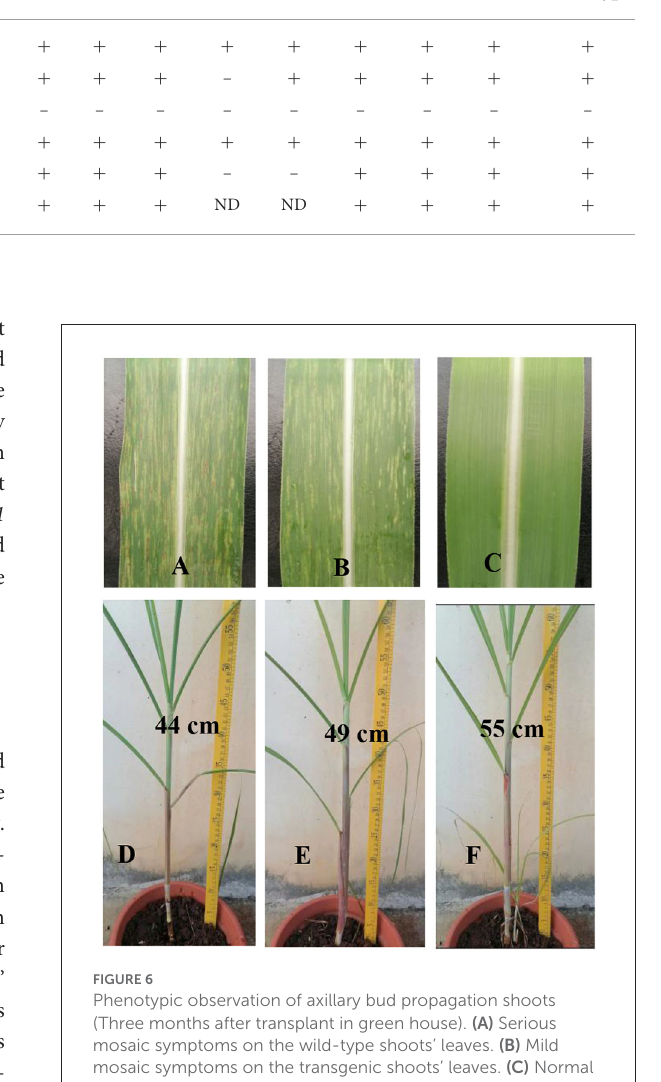
TABLE 1 Molecular analysis of resistant shoots. Resistant shoots